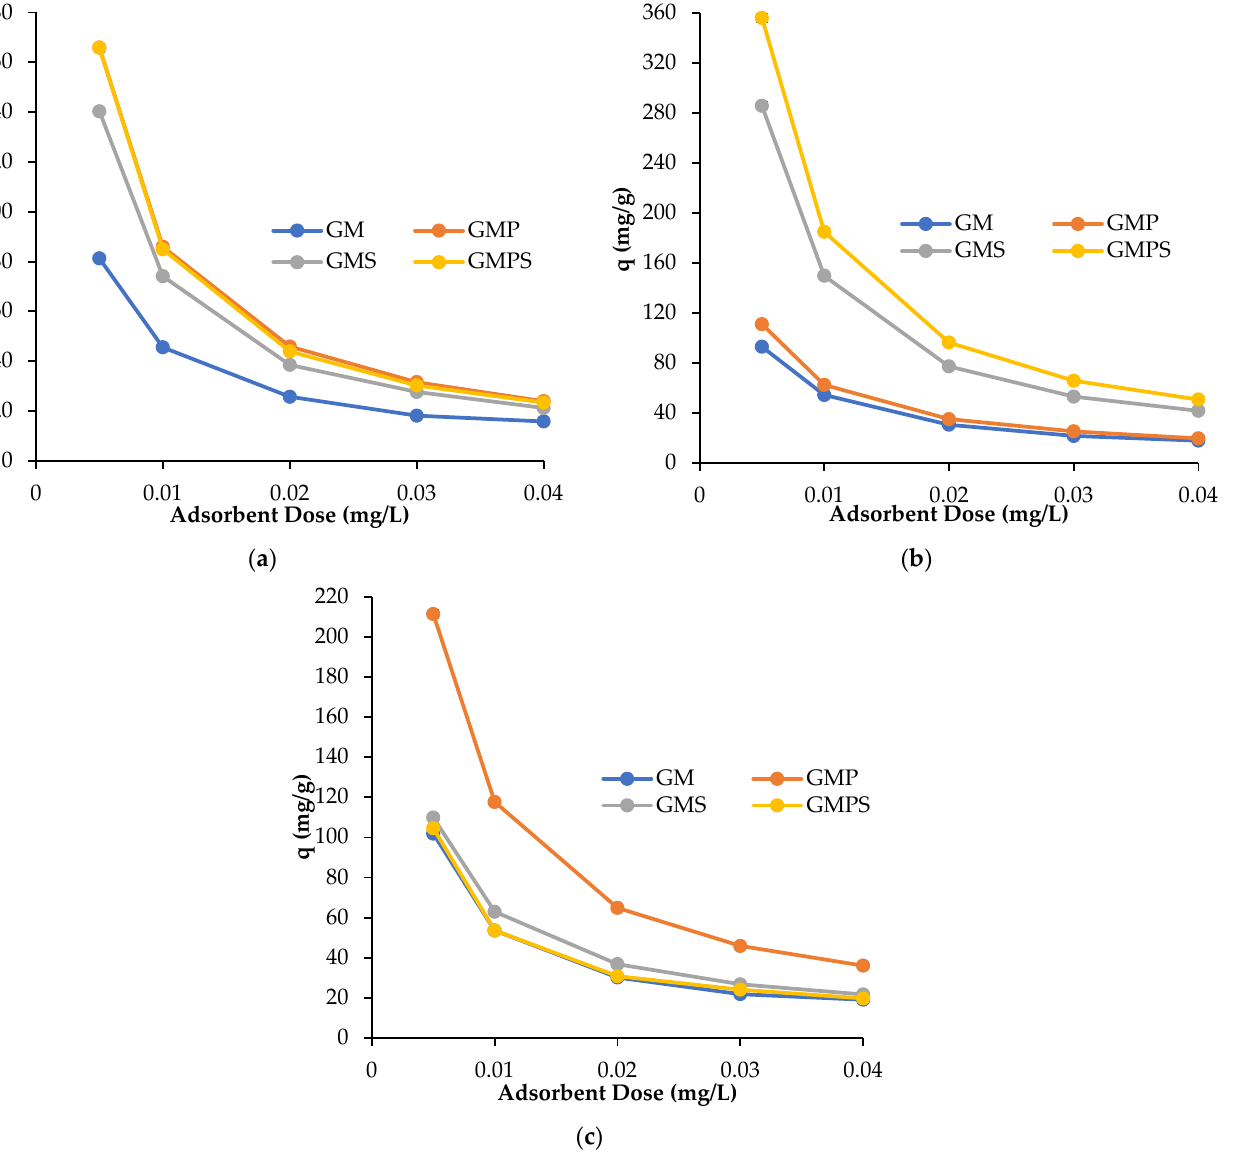
Figure 2. Effect of adsorbent dose on adsorption capacity ( a ) Foron black dye, ( b ) Foron blue dye ( c ), and Foron red dye.